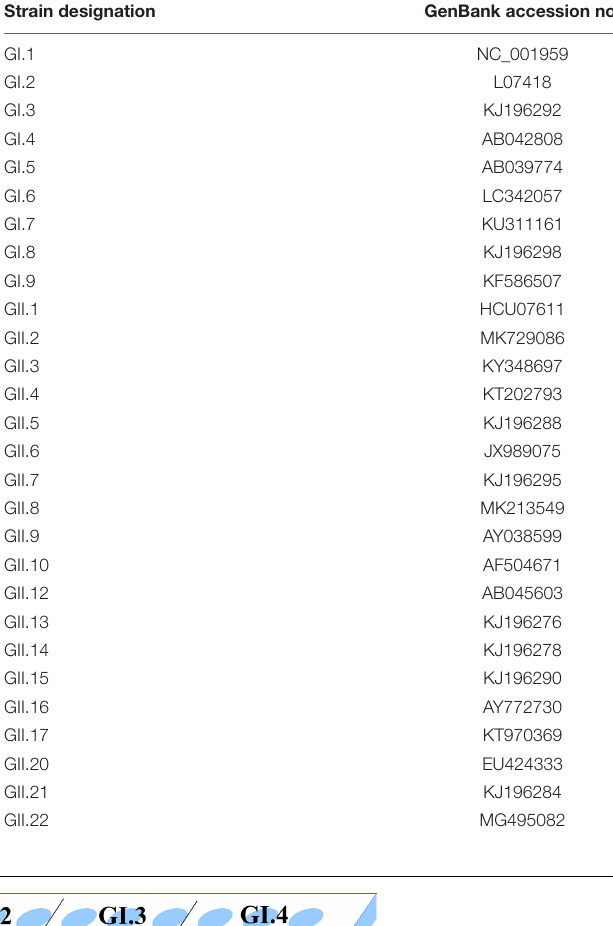
TABLE 1 | Selection of norovirus strains used as coating antigens.